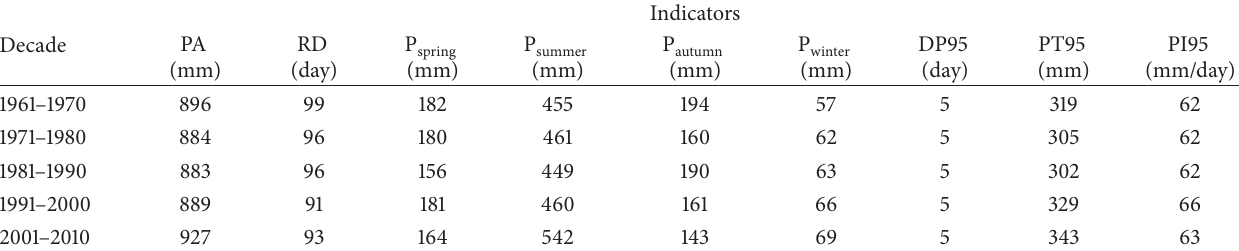
Table 2: Decadal change of different indicators concerning the precipitation in the